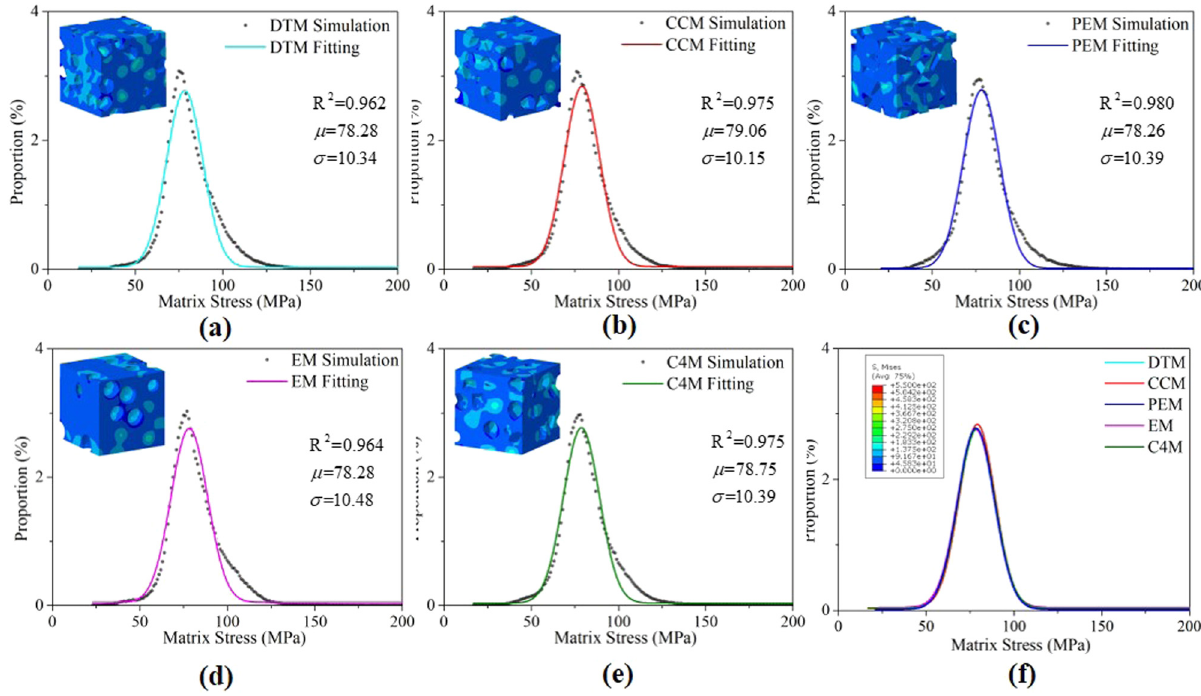
Figure 7: Matrix micro - stress distribution at 0.1% strain: ( a ) DTM, ( b ) CCM, ( c ) PEM, ( d ) EM, ( e ) C4M, and ( f ) fi tting curves.